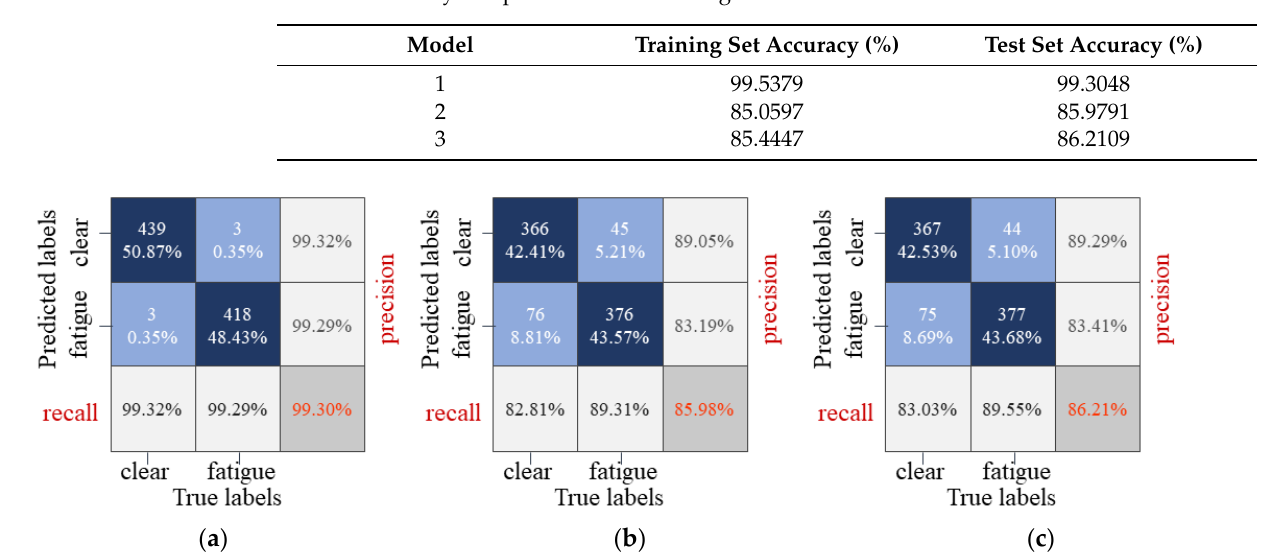
Table 2. Accuracy comparison of the three algorithms.